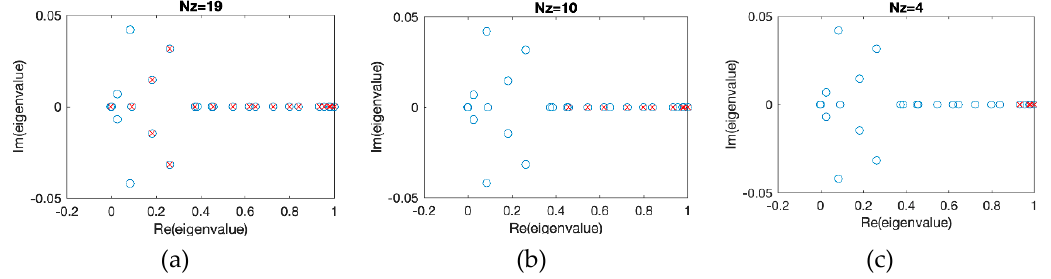
Figure 5. Eigenvalues of (cid:101) A (the matrix that contains coherent structure for the DMD method as in